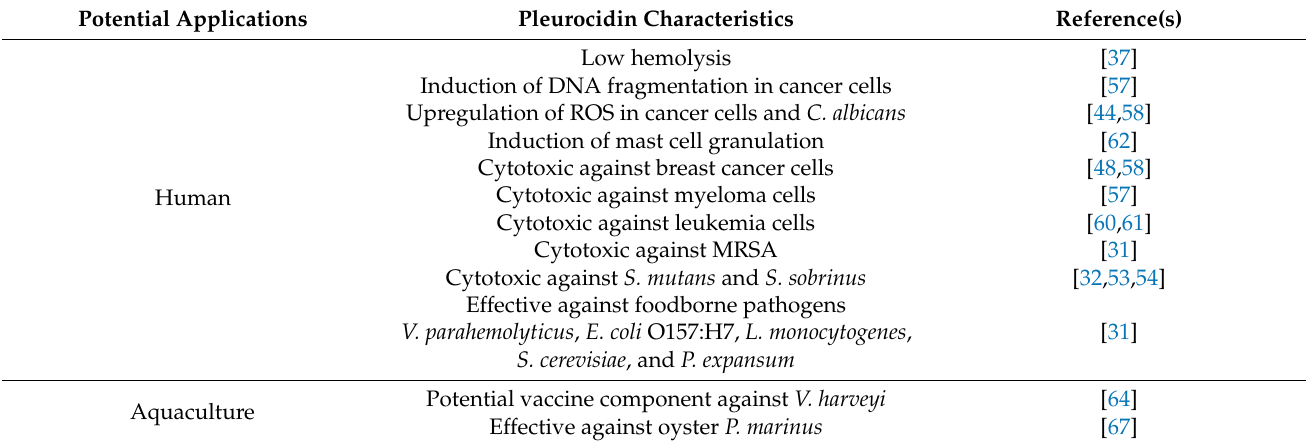
Table 1. Important characteristics of pleurocidin relevant to the peptide’s potential human and aquaculture applications. Potential